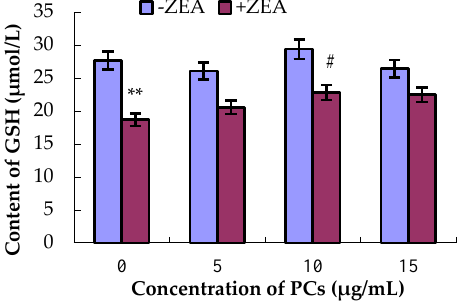
Figure 6. Effects of different concentrations of proanthocyanidins (PCs) on the content of glutathione (GSH) exposed to zearalenone (ZEA) (65 µ mol/L). Content of GSH significantly decreased when cells were exposed to ZEA, while the content of GSH did not decrease when cells were treated with PCs. The content of GSH increased when the cells were co-treated with PCs/ZEA. ** p < 0.01 vs. control group; # p < 0.05 vs. ZEA-treated group.